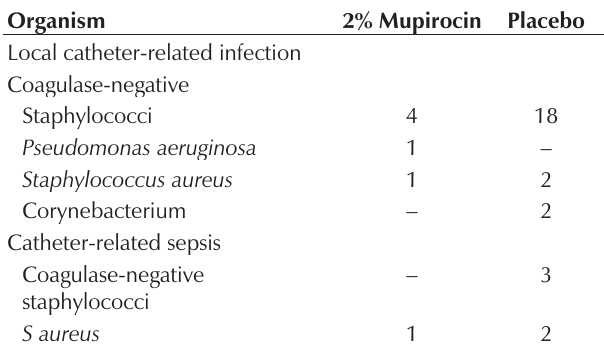
TABLE 3 Microorganisms causing local catheter-related infections and catheter-related bacteremia in 57 and 69 catheter insertions receiving mupirocin or placebo, respectively, at the